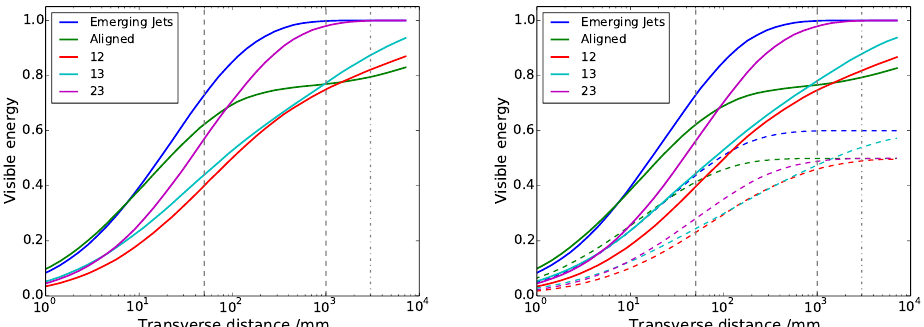
Figure 8. Average visible energy (de(cid:12)ned as the energy transferred to SM states when dark pions decay) as a function of transverse distance from the interaction point at the 14 TeV LHC. The (cid:13)avour scenarios corresponding to the di(cid:11)erent lines are outlined in table 3 and described in the text. On the right we show, in addition, the fraction of energy in heavy (cid:13)avours ( b -jets) as dashed lines. The parameters chosen here are m (cid:25) = 20 GeV, f D = m (cid:25) , (cid:20) 0 =0.09, m X = 1 TeV. D D to the quark mass factor appearing in equation (3.6), the dark pions will tend to have a large branching ratio to b (cid:22) b , b (cid:22) q and q (cid:22) b pairs ( q = d; s ), and hence these \emerging